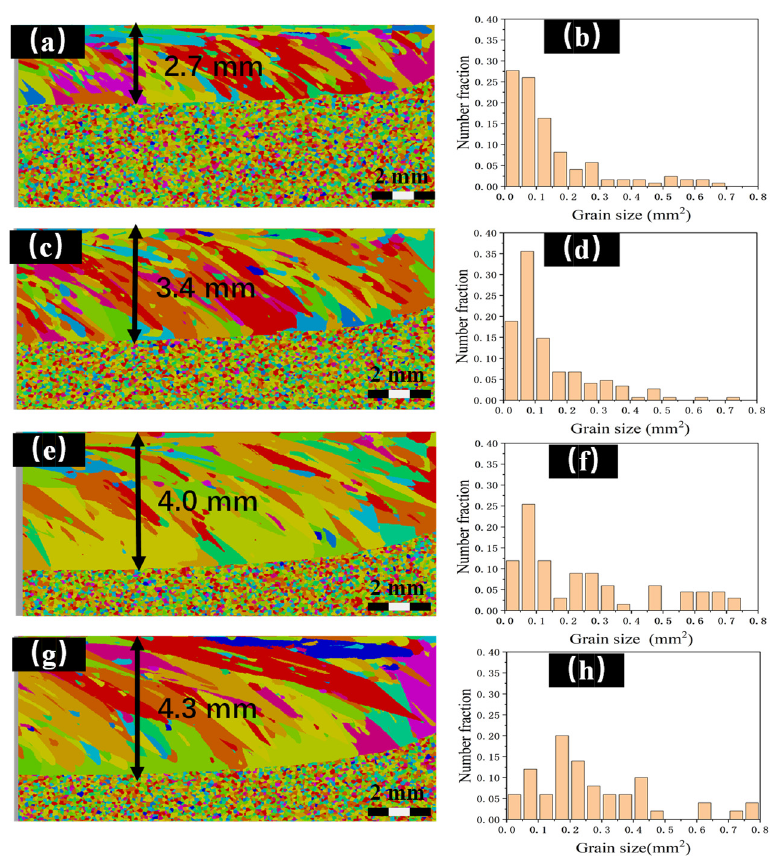
Figure 12. Grain morphologies and sizes at different laser power levels: ( a , b ) P = 1000 W; ( c , d ) P = 2000 W; ( e , f ) P = 3000 W; ( g , h ) P = 4000 W.